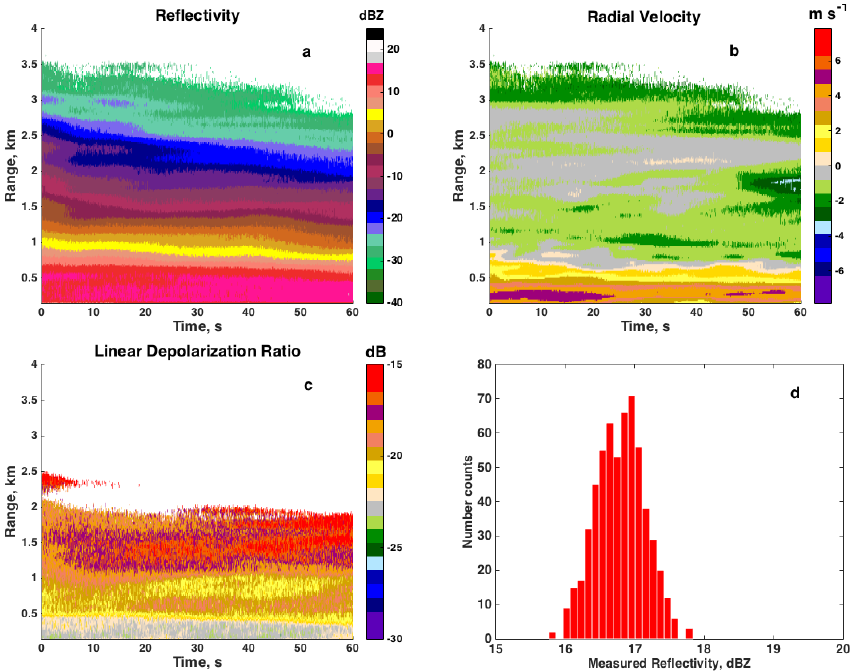
Figure 9. Radar measurements in stratiform rain. The HCR was on the ground and the beam was pointing at 30 ◦ elevation. The B-scan display shows time versus range for the following: (a) reflectivity, (b) velocity and (c) LDR. A histogram of reflectivity at 200m is shown in (d)